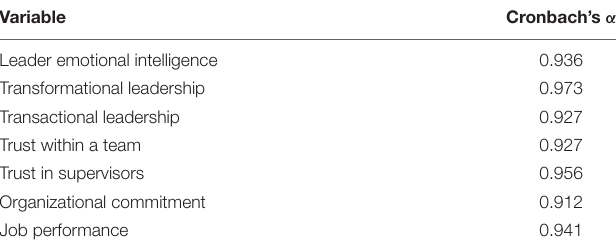
TABLE 2 | Cronbach’s α of each latent variable.